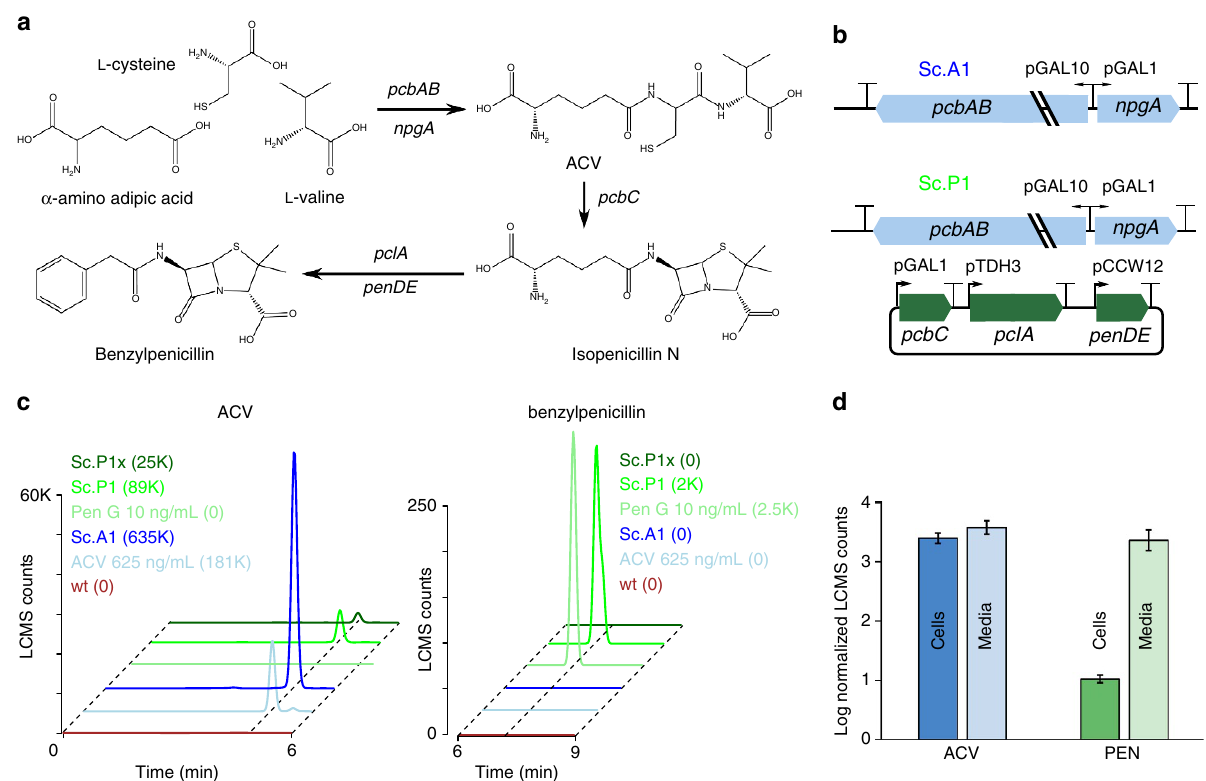
Figure 1 | Production of benzylpenicillin by engineered S. cerevisiae . ( a ) Benzylpenicillin biosynthesis requires a five-enzyme pathway where alpha-aminoadipic acid, cysteine and valine are first converted to the tripeptide ACV by pcbAB and npgA. ACV is then converted to benzylpenicillin by pcbC , pclA and penDE . ( b ) Strain Sc.A1 ( S. cerevisiae BY4741 with genomically integrated pcbAB and npgA genes) produces ACV as observed by LCMS analysis. Parallel diagonal lines in the cartoon for the pcbAB gene represent that this very large gene is not drawn to scale with npgA . To produce benzylpenicillin, strain Sc.A1 was transformed with a plasmid expressing pcbC , pclA and penDE to make strain Sc.P1. ( c ) LCMS counts versus retention time is shown for the detection of ACV (left) and benzylpenicillin (right), for an ACVstandard (light blue) and a benzylpenicillin standard (light green) as well as for supernatant from a wild-type culture (brown), an Sc.A1 culture (blue), an Sc.P1 culture (green) and a culture of strain without peroxisomal targeting of pclA and penDE (Sc.P1x, dark green). All cultures were grown at 20 (cid:2) C in the presence of 5mM AAA and 0.25mM phenylacetic acid (required for the last step of benzylpenicillin biosynthesis). Dashed diagonal lines indicate the bounds of the x axis and the centres of the relevant peaks. Rounded LCMS counts of the tallest peak for both ACVand benzylpenicillin detection are indicated on the y axis, and areas under each peak are given in parentheses in the legend. Mass spectra are included as Supplementary Data 2. ( d ) Benzylpenicillin is secreted as shown by concentration-normalized log 10 values of LCMS counts for cell pellets and media for both ACV and benzylpenicillin from Sc.P1 cultures grown as in c . Error bars show s.d. for three biological